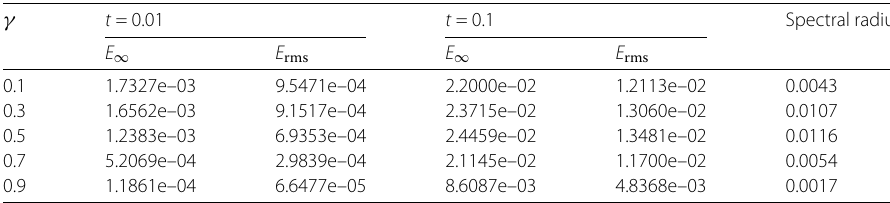
Table 3 Error norms of Example 5.2 at J = 4, τ = 0.001, θ = 1 γ